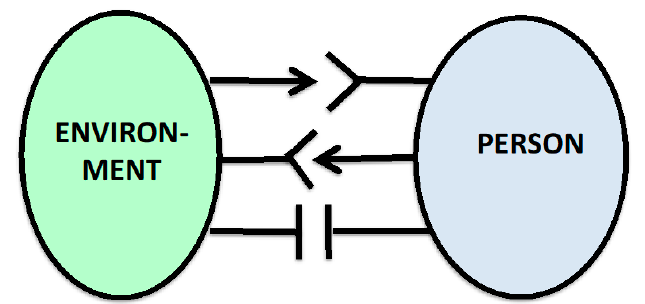
Figure 2. Person – environment relations as a structure of single or double give – take relations, or Figure 2. Person–environment relations as a structure of single or double give–take relations, or give – give, or take – take relations, and additional reciprocal rejection relations. The overall give–give, or take–take relations, and additional reciprocal rejection relations. The overall relationship relationship can result in pathogenic imbalances. can result in pathogenic